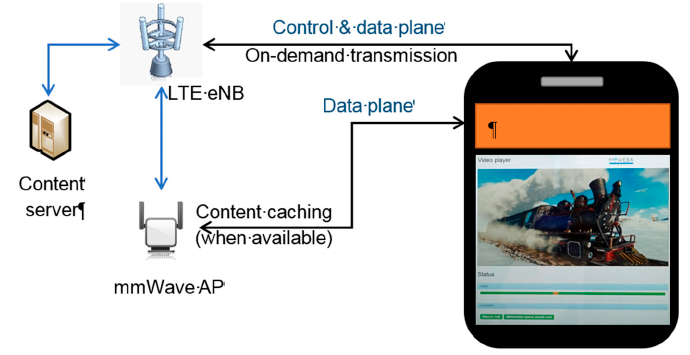
Figure 16. Caching PoC demonstration.